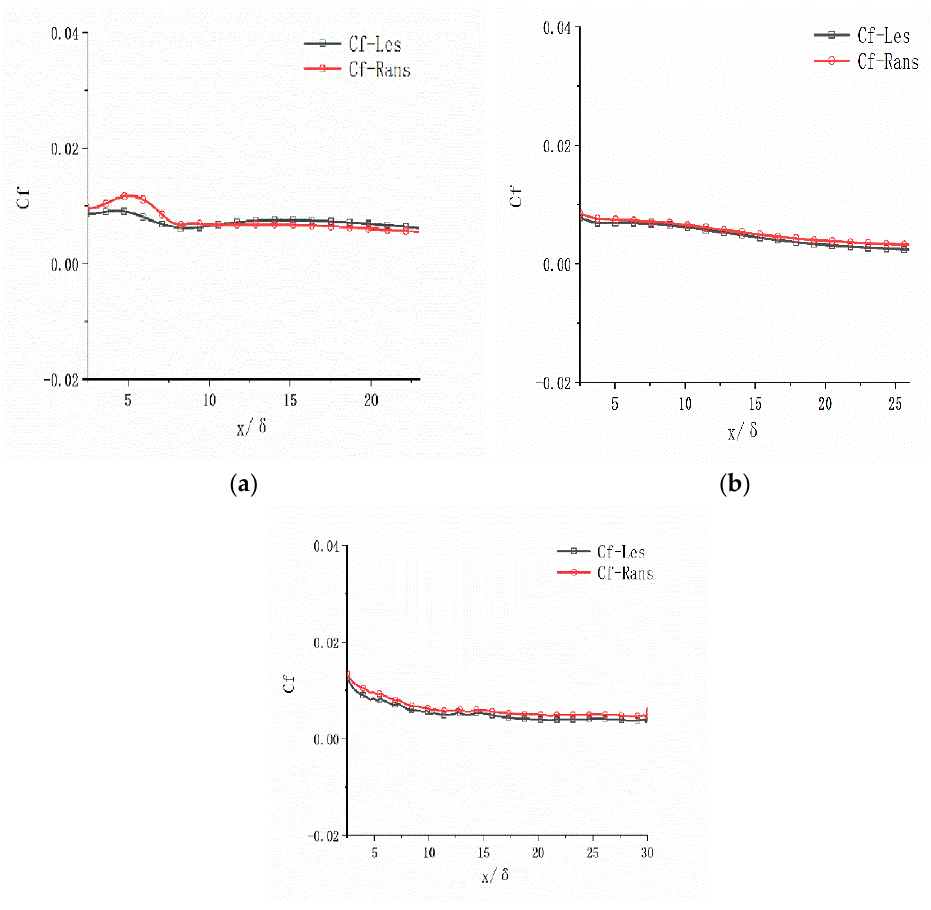
Figure 11. Distribution of frictional drag coefficient along the flow direction at the spanwise z = 0.0005 m of the smooth plate; ( a ) 0.3 Ma; ( b ) 0.5 Ma; and ( c ) 0.8 Ma.